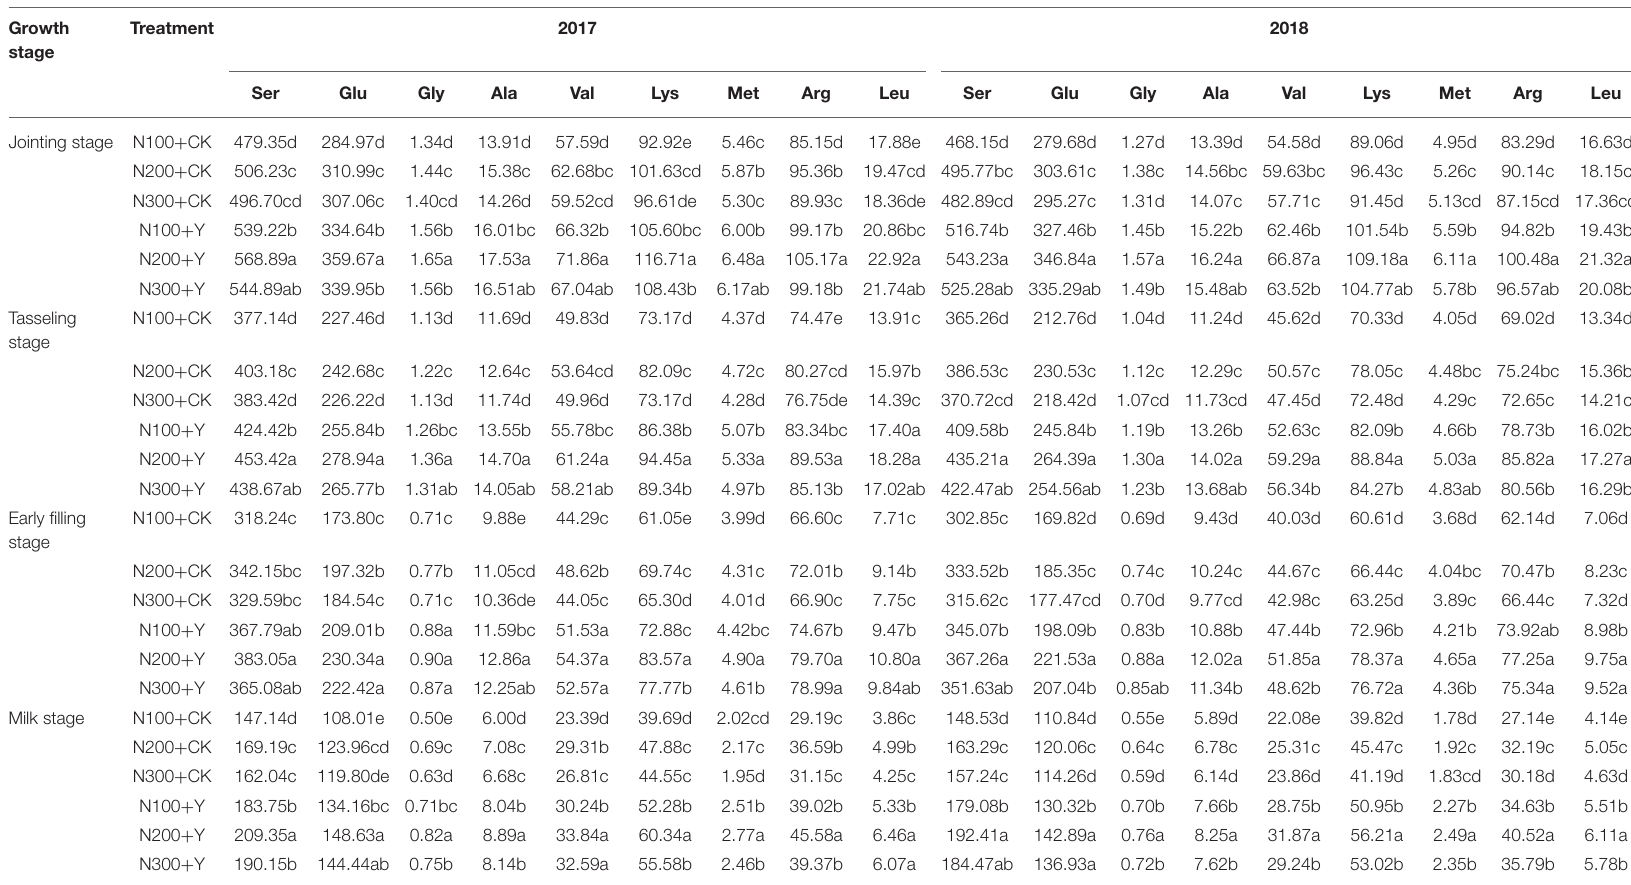
TABLE 2 | Effects of chemical control and nitrogen fertilizers on amino acids concentrations ( µ g h − 1 plant − 1 ) in root-bleeding sap during the maize growing period in 2017 and 2018. Growth